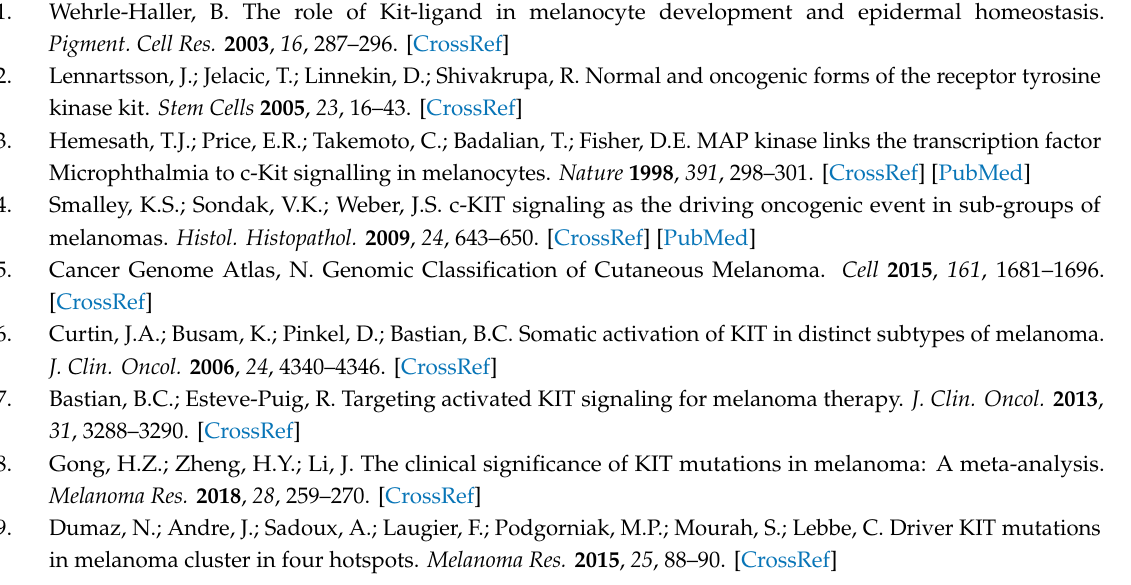
Figure S1: Expression of KIT at the membrane of melanoma cell lines, Figure S2: Expression of FGFR in melanoma cell lines, Figure S3: Phospho-arrays of HBL cells treated with nilotinib and FGF, Figures S4–S6: Uncropped Western blot bands, Table S1: Immunohistochemistry staining for phospho-MEK and phospho-ERK in tumors of patients treated with nilotinib, according to their best response following